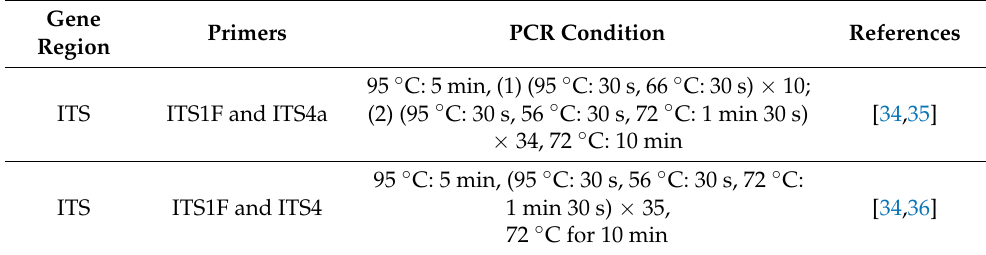
Table 1. Gene regions, respective primer pairs and PCR conditions used in the study. Gene Region